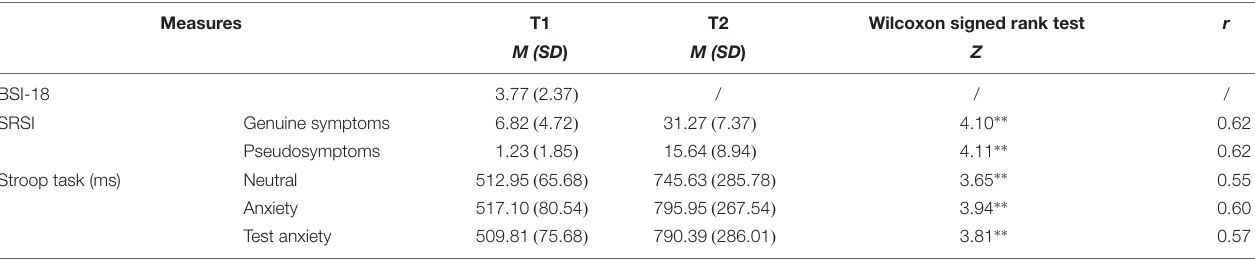
TABLE 1 | Means and standard deviations of the BSI-18 scores (only T1), SRSI genuine symptoms and pseudosymptoms scores (T1 and T2), and MST latency data on neutral, anxiety, and test anxiety words in both conditions ( N = 22). Measures T1